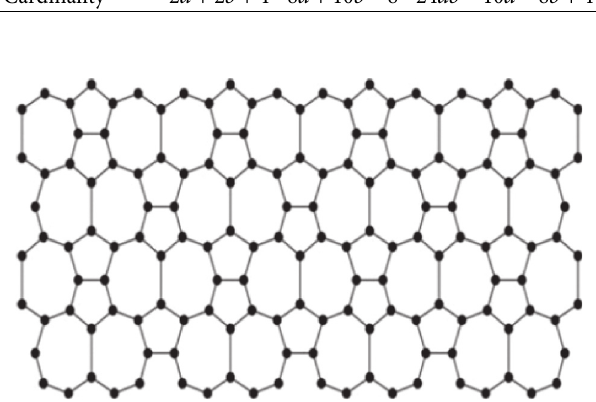
Figure 1: Pent-heptagonal nanosheet VC